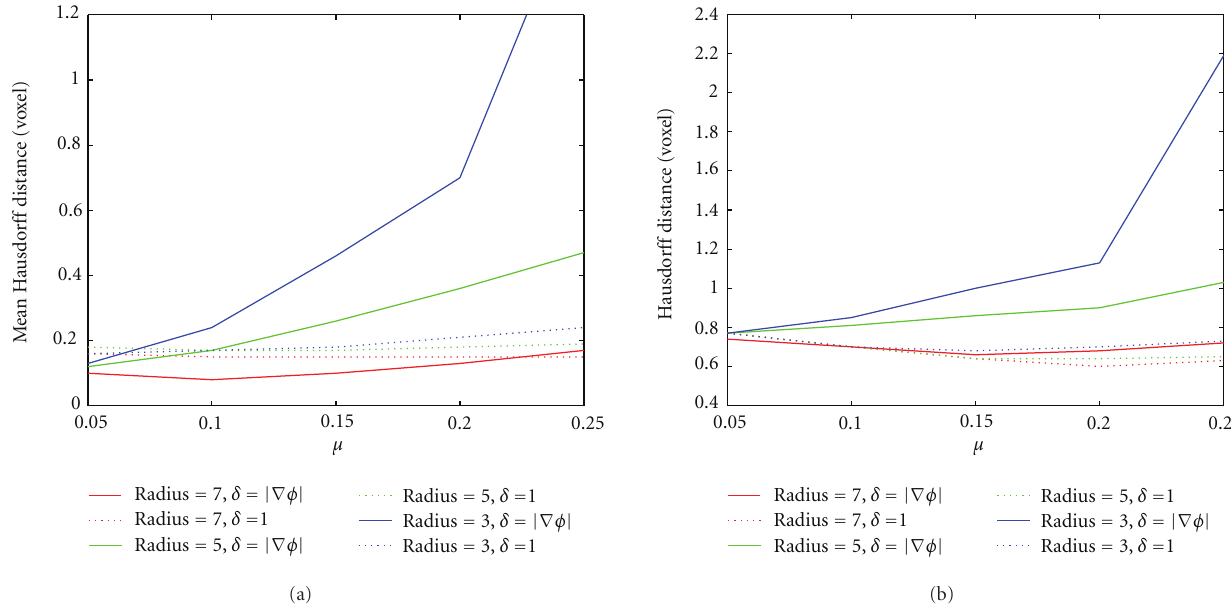
Figure 4: Graph of Mean Hausdor ff Distance and Hausdor ff Distance between surfaces of original and segmented spheres. The distances are expressed in function of scale parameter. Solid line represents results using (4). Dashed line represents results using (5) are in red, spheres of radius 7. 5 in green, and 3 in blue. The model described in (5) is more robust than the model given by (4).